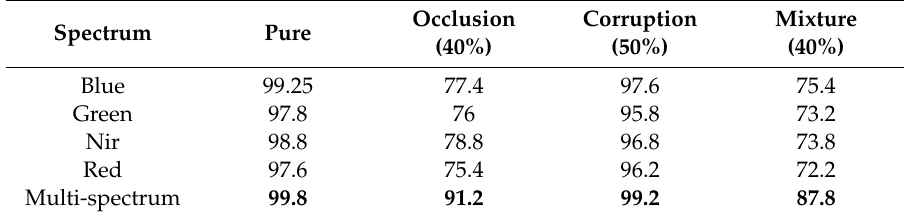
Table 5. Recognition rates (%) of multispectral and single-spectrum palmprint recognition on the PolyU